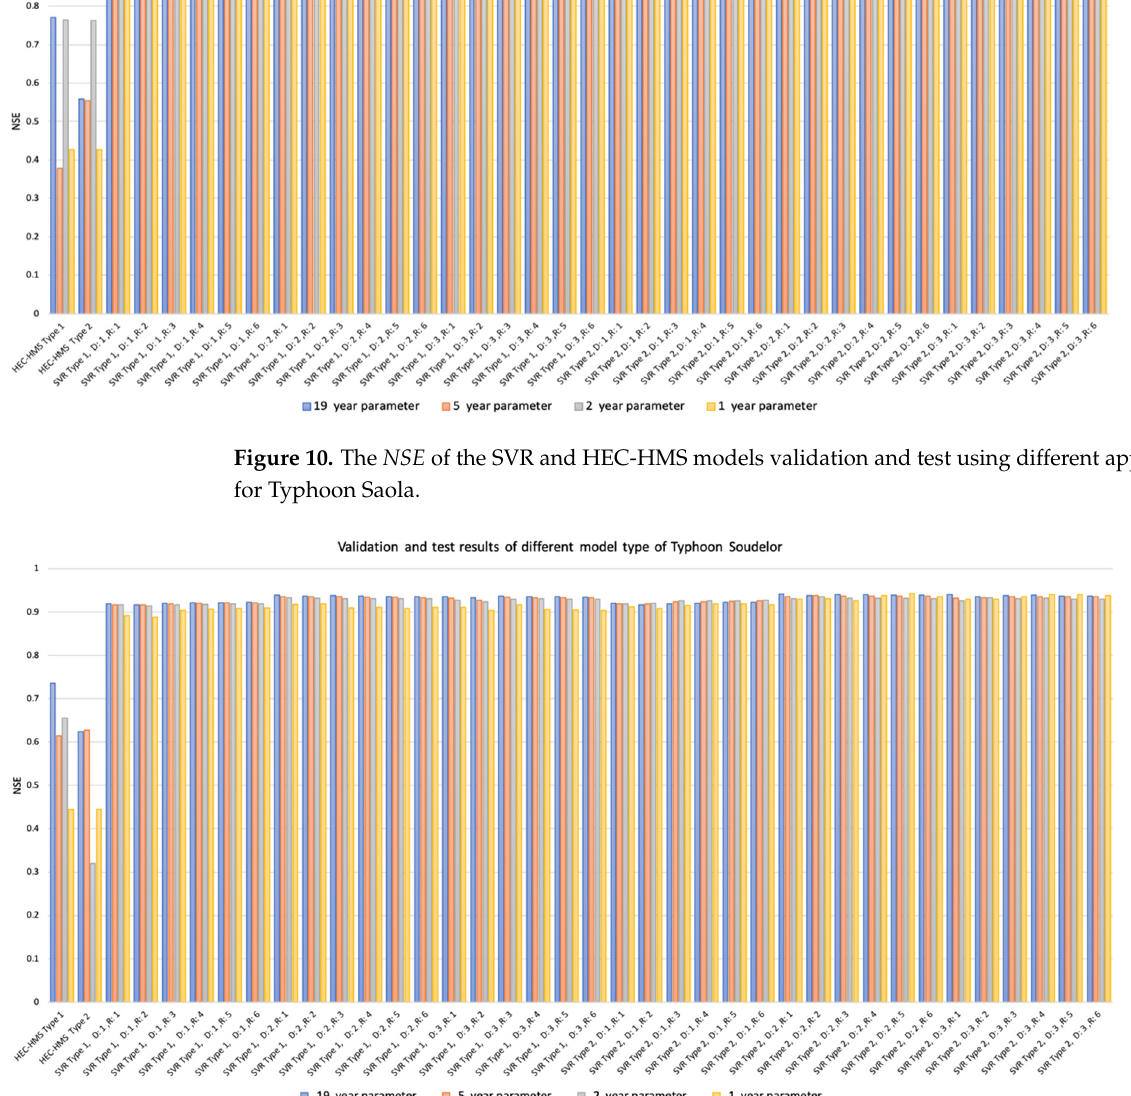
Figure 11. The NSE of the SVR and HEC-HMS models validation and test using different approaches for Typhoon Soudelor.